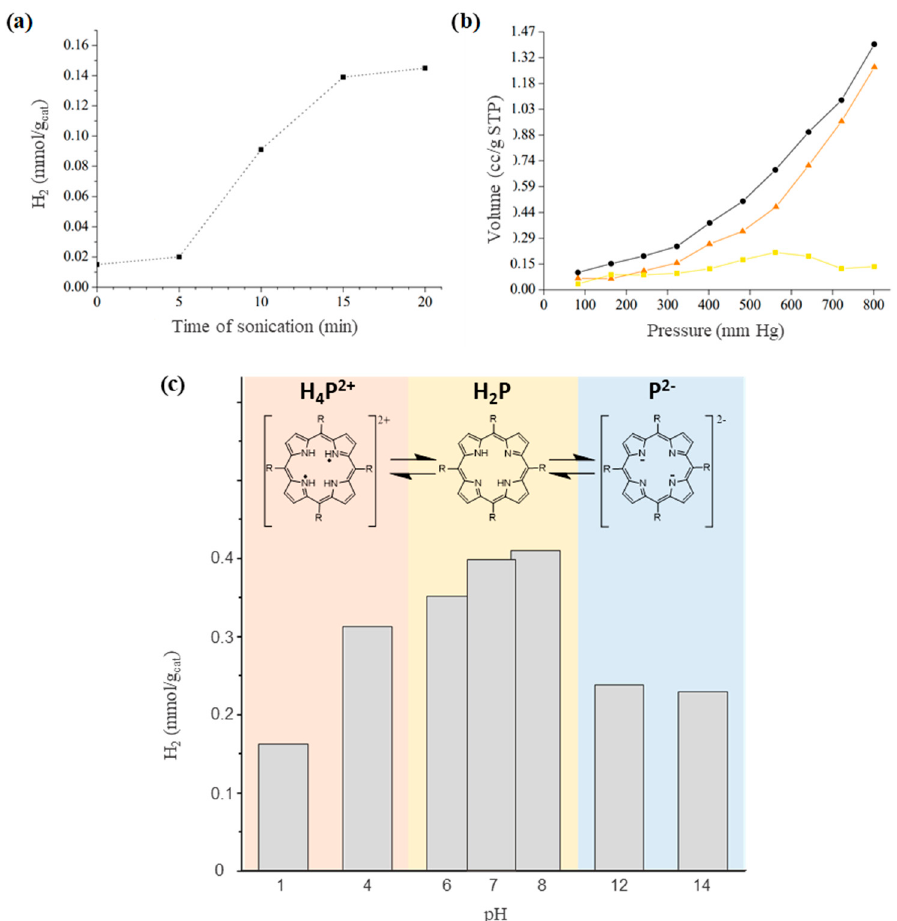
Figure 6. ( a ) Optimization of sonication time experiment. ( b ) Hydrogen chemisorption ( ■ ), phy ‐ sisorption ( ▲ ) and combined absorption ( ● ) of COP–3. ( c ) Hydrogen production per gram of COP–3 after PWS reaction at different pH.